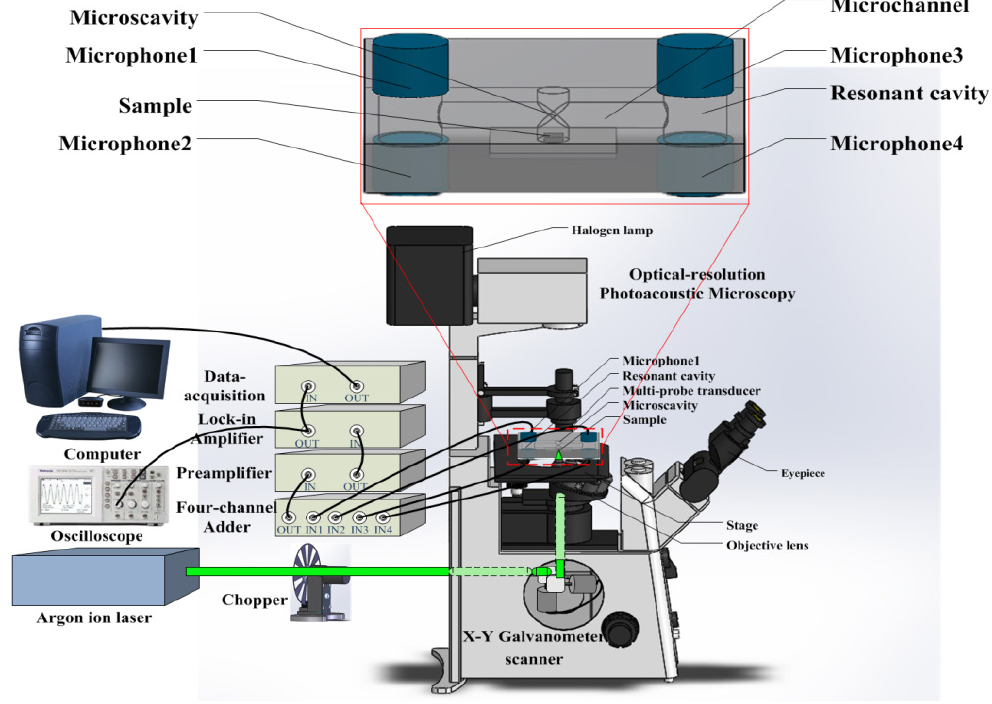
Fig. 2. Schematic of multi-probe detection CW-mode OR-PAM